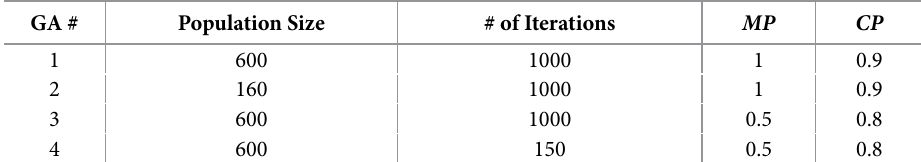
Table 2. Best levels of parameters observed in the pilot experimentation GA